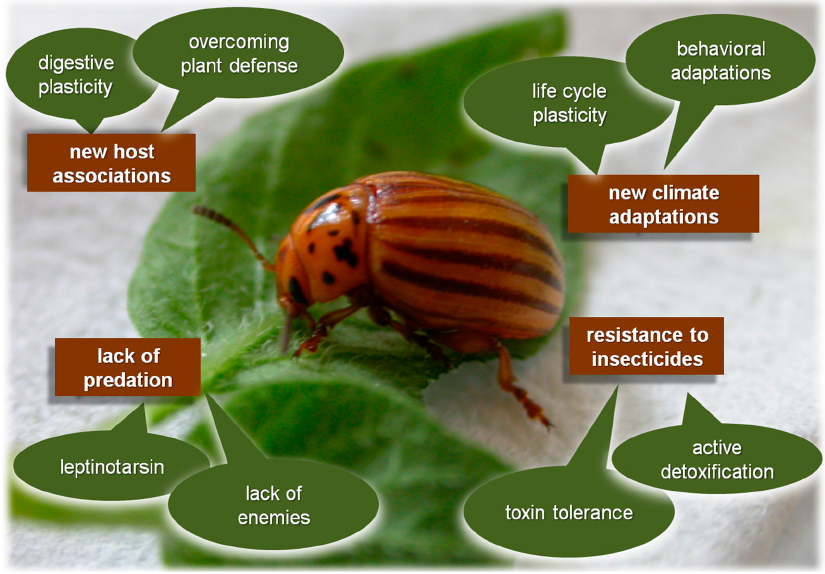
Figure 1. Different eco-physiological adaptations that give the Colorado potato beetle (CPB) characteristics of one of the most invasive species worldwide, and the “superpest” status.